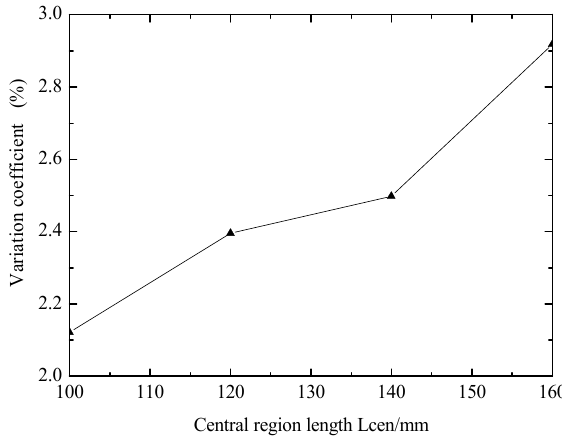
ff ect of central region length on stress in central region. Figure 4. Effect of central region length on stress in central region. Figure 4. E